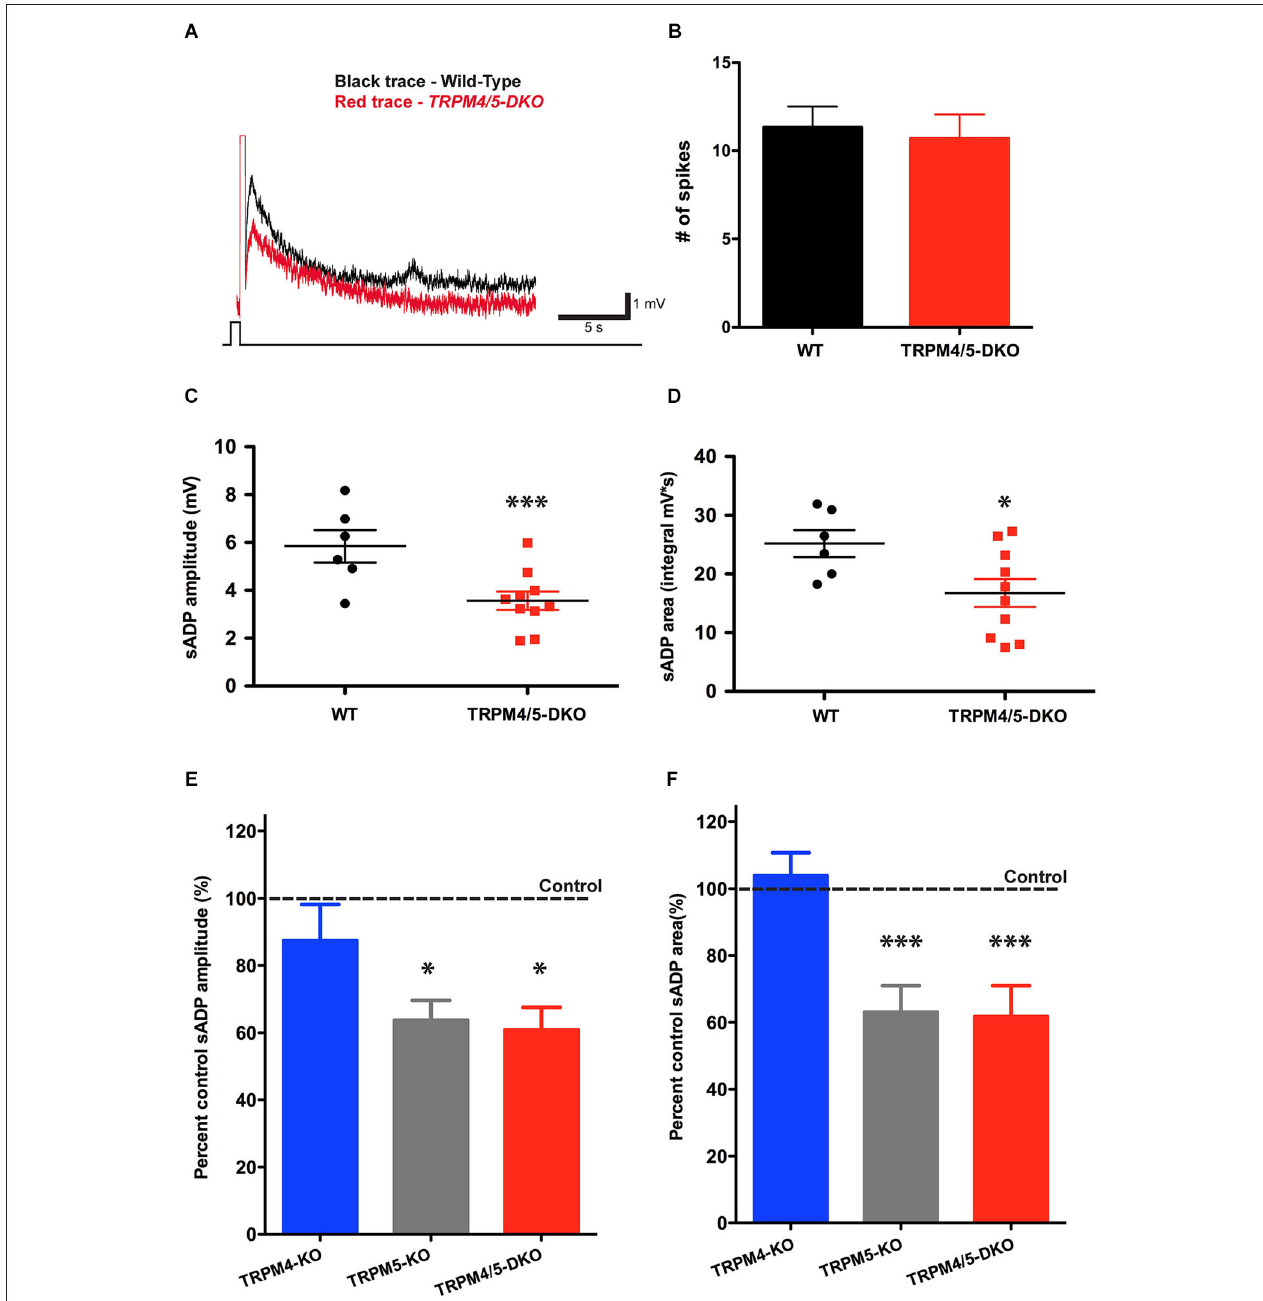
indicates P < 0.01) (C) and area ( n = 6–10, * indicates P < 0.05) (D) compared to wild-type littermate controls. (E,F) Bar graphs showing sADP amplitude (E) and area (F) in three different genotypes expressed as percentage of sADP in wild-type littermate controls. Normalized sADP amplitude and sADP area show significant differences between Trpm4 − / − KO vs. Trpm5 − / − KO and between Trpm4 − / − KO vs. Trpm4/5 -DKO mice (one-way ANOVA; n = 10–12, * indicates P < 0.05 and *** indicates P < 0.0001,